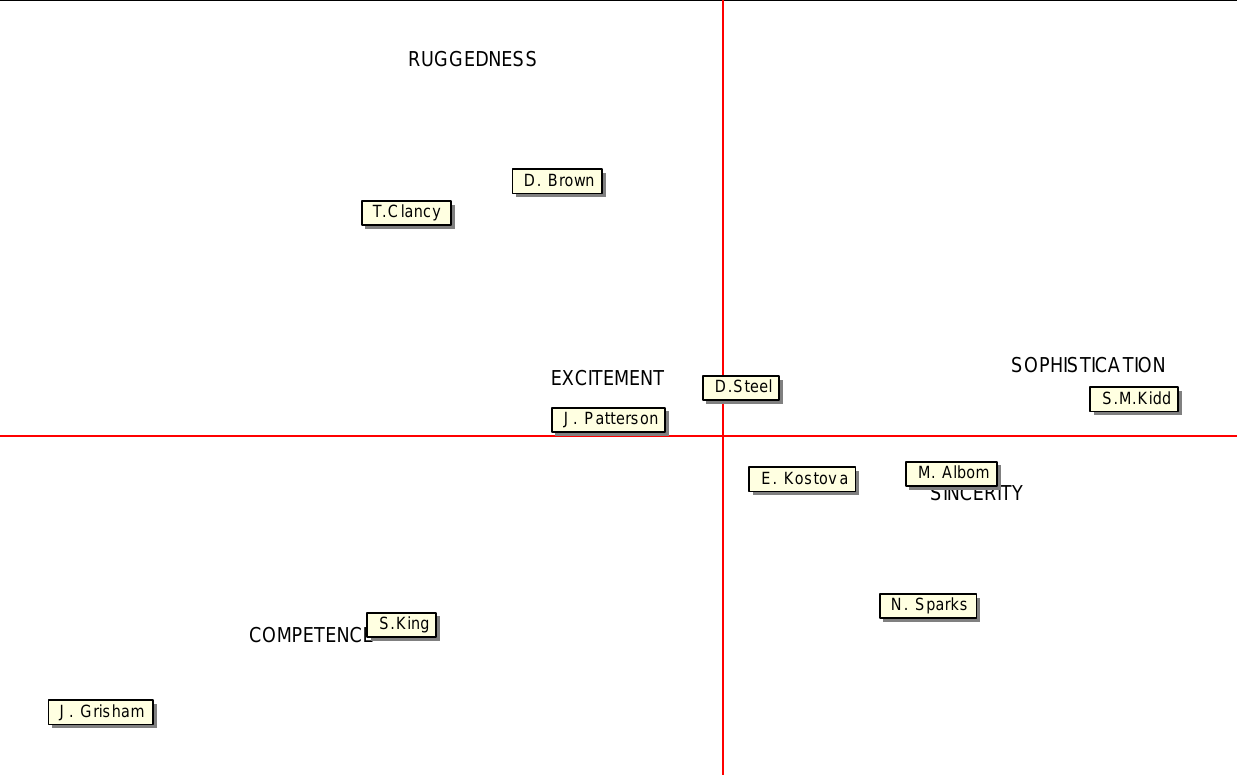
Figure 1. Correspondence analysis map of 10 bestselling authors’ official websites in relation to the five brand personality